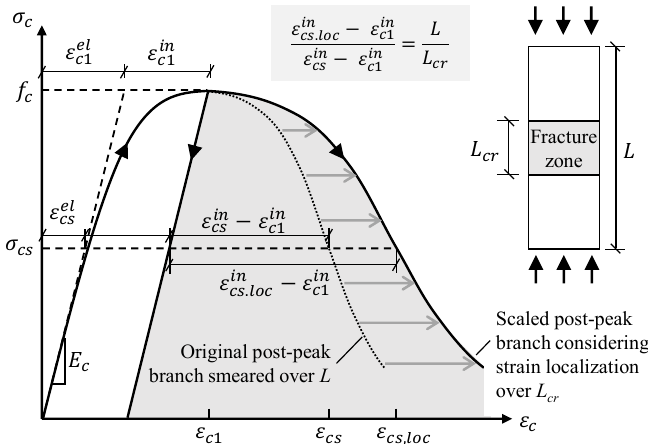
Figure 3. Modification of the post-peak softening branch of the constitutive model for concrete in compression originally expressed by the mean strain smearing over the whole length of specimen L to consider the strain localization in the critical fracture zone with the length of L cr .